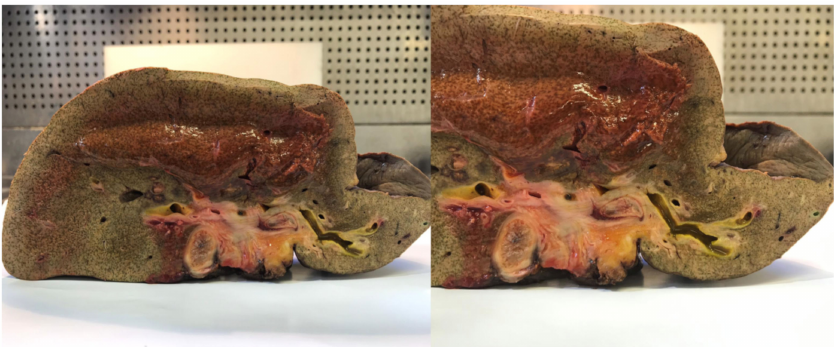
Figure 2. E ff ect of brachytherapy on bile ducts (explanted